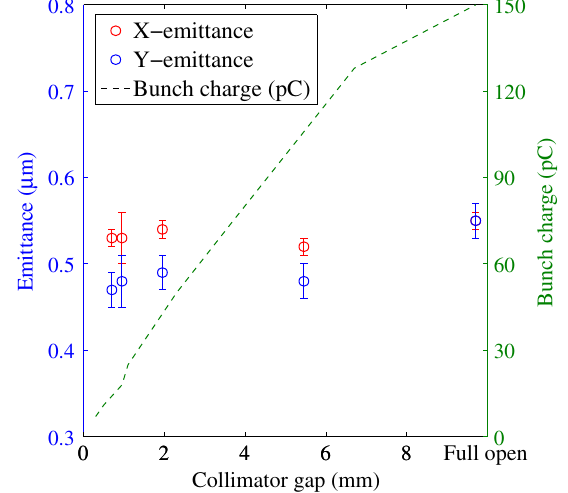
FIG. 7. Measured x=y -emittances and charge vs collimator gap. The collimator gap g ¼ 10 cm for the full open case.